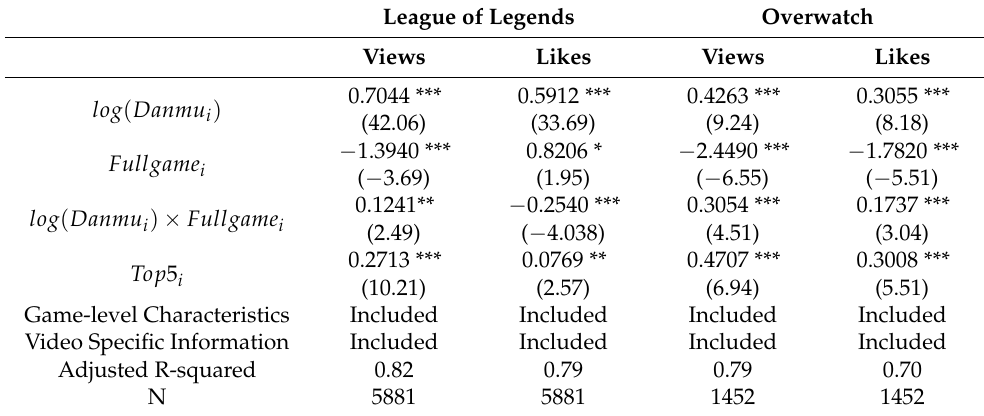
Table 5. Estimated Moderating Effects of Full-length Match on the Impact of